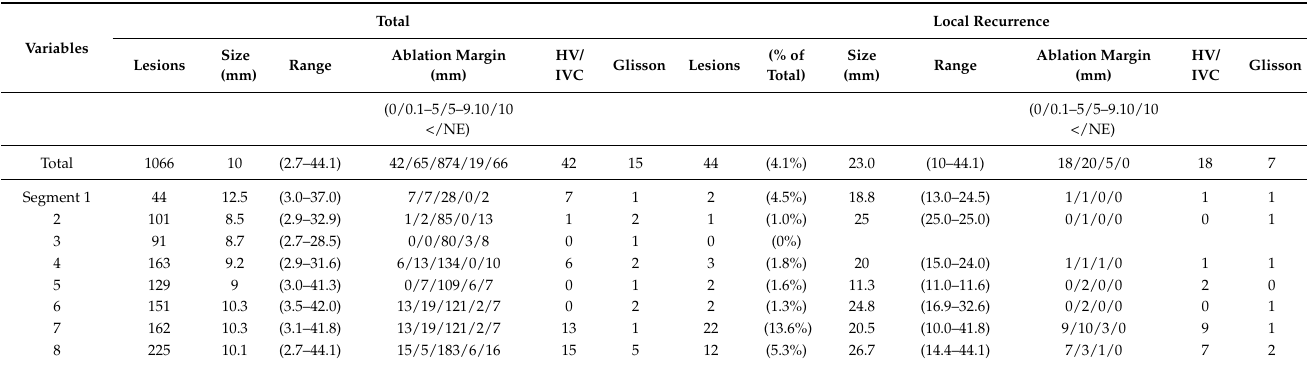
Table 3. Characteristics of tumorous lesions treated with MWA.